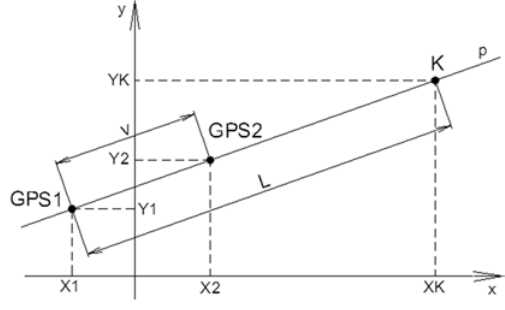
Fig. 10. GPS1, GPS2 and bucket-wheel K centre horizontal